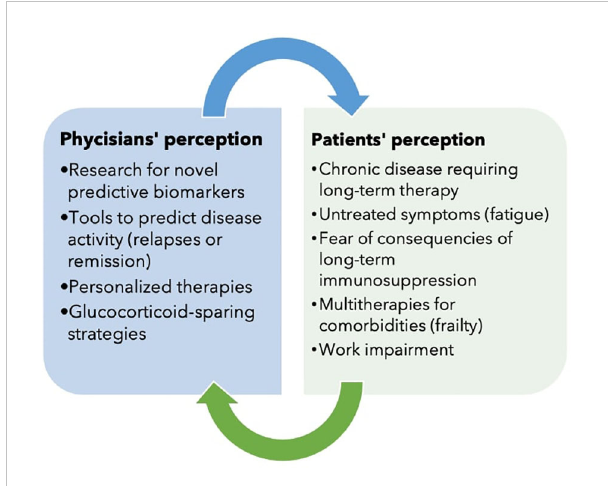
FIGURE 1 The physicians ’ and patients ’ perceptions compared: What matters